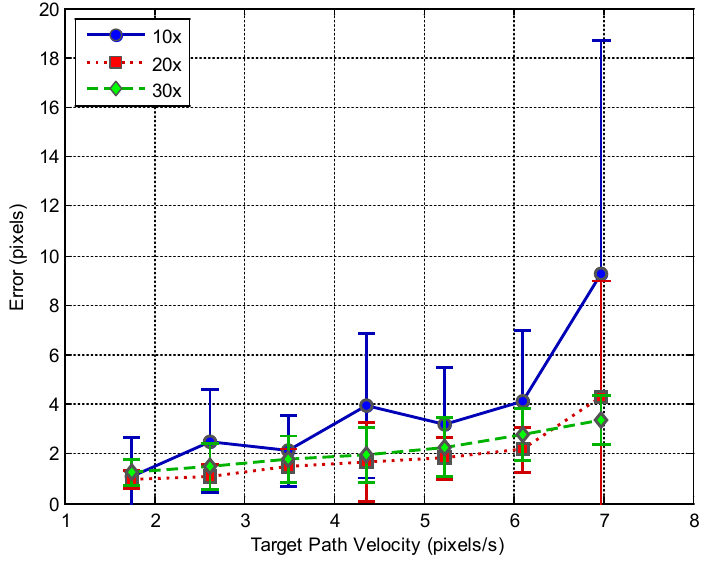
Figure 10. Average steady state tracking error (in pixels) with error bars indicated one standard deviation for a range of velocities and magnifications for a star microrobot following a circular path at three different magnifications (10×, 20×, and 30×). The pixel resolutions are approximately 9.8, 6.5, and 3.2 μm /pixel,